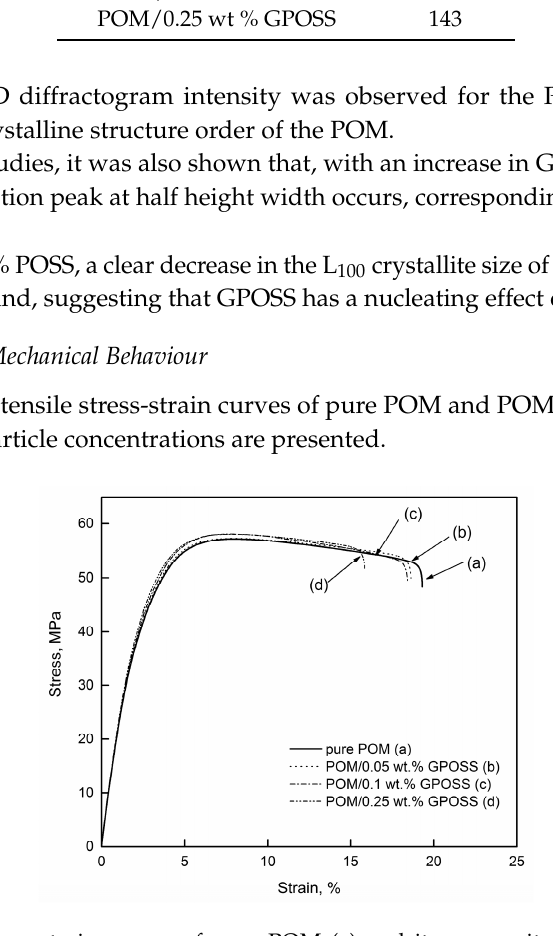
Figure 7. Tensile stress-strain curves of pure POM ( a ) and its composite with different GPOSS concentrations: ( b ) 0.05 wt. %; ( c ) 0.1 wt. %; ( d ) 0.25 wt. %. concentrations: ( b ) 0.05 wt %; ( c ) 0.1 wt %; ( d ) 0.25 wt %.